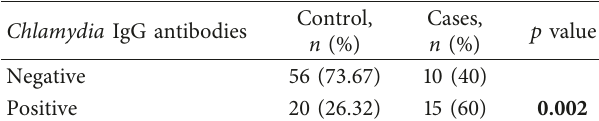
Table 3: Confirmed Chlamydia trachomatis IgG antibodies in both controls and